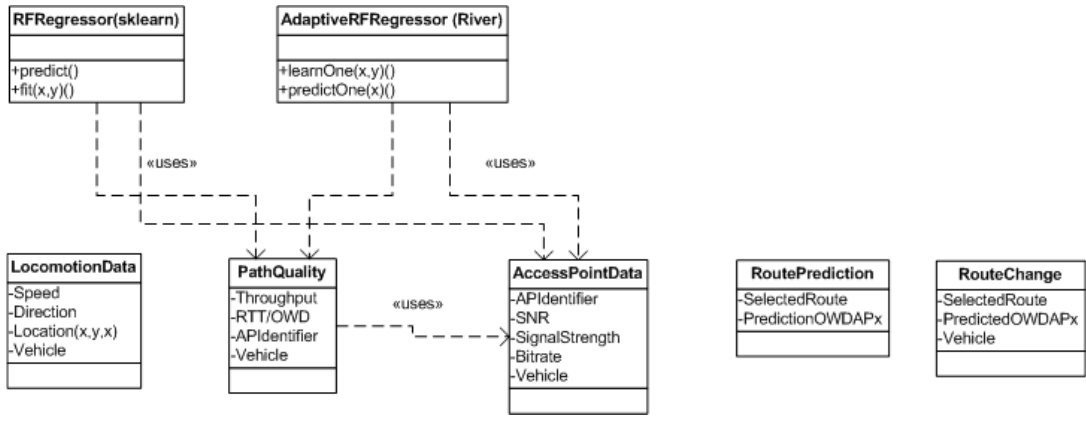
Figure 6. Class diagram illustrating a data viewpoint of the architecture.